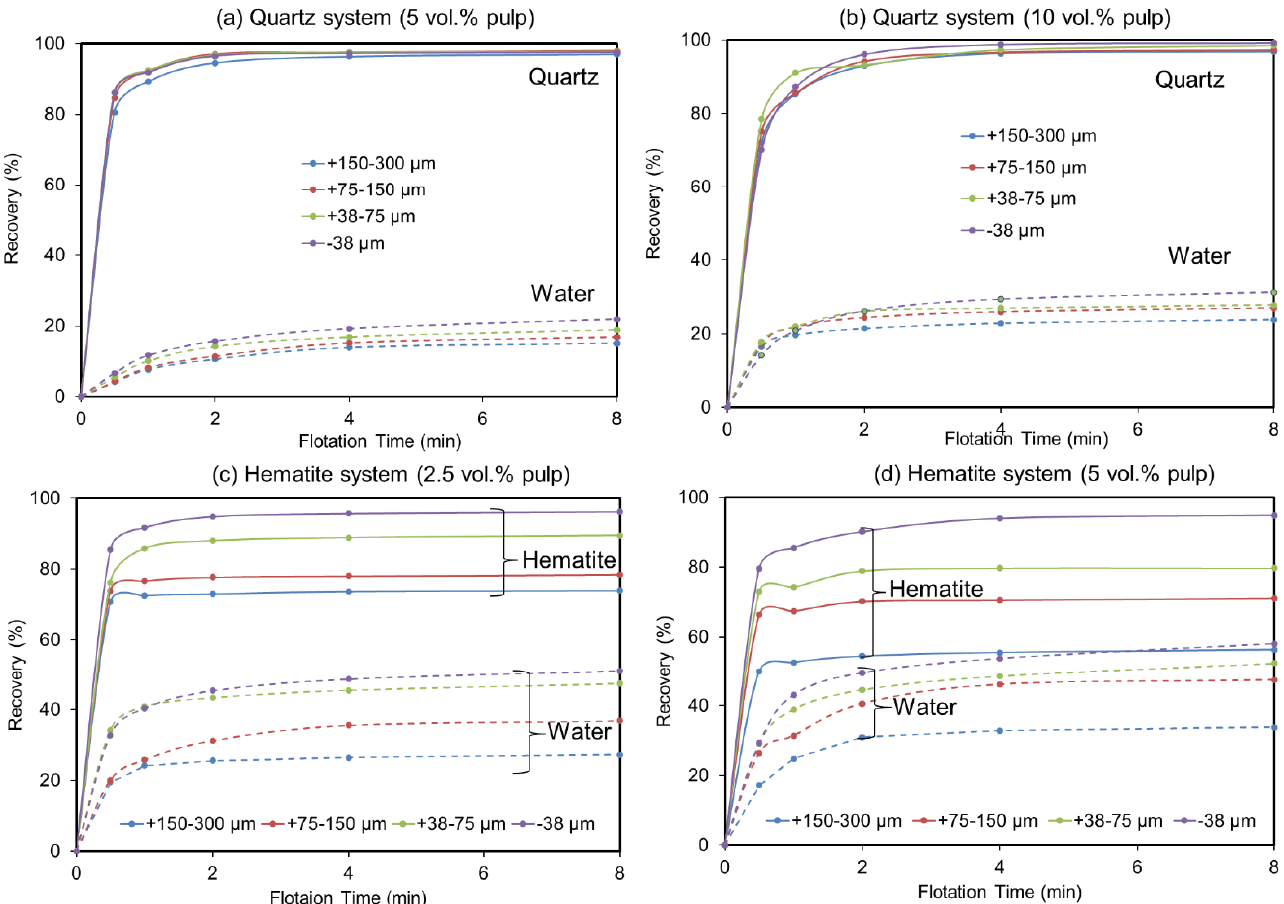
Figure 1. Influence of size fraction and solid concentration on the recovery of quartz, hematite, and water; ( a – d ) quartz 5 vol.%, quartz 10 vol.%, hematite 2.5 vol.%, and hematite 5 vol.%, respectively.